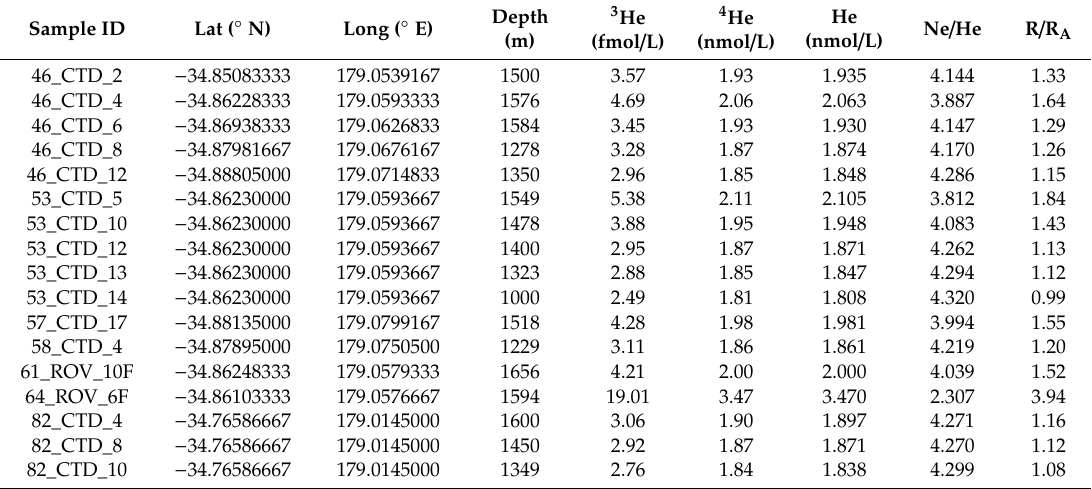
Table 4. Helium isotope data at Brothers volcano acquired during cruise SO253. R / R A reports the 3 He / 4 He isotope ratio of the sample divided by 3 He / 4 He isotope ratio of the atmosphere e.g.,